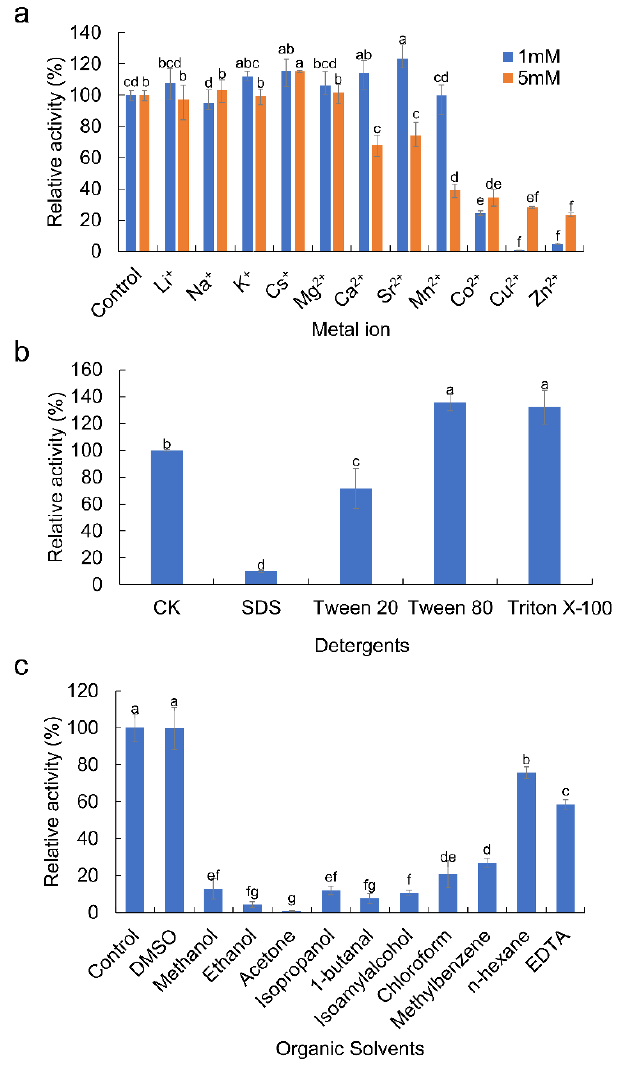
Figure 5. Effect of metal ions, detergents and organic solvents on esterase activity of EstDR4. ( a ) Effect of metal ions (1 and 5 mM) on EstDR4 activity: Li + , Na + , K + , Cs + , Mg 2+ , Ca 2+ , Sr 2+ , Mn 2+ , Co 2+ , Cu 2+ and Zn 2+ . ( b ) Effect of detergents on enzyme activity: SDS, Tween 20, Tween 80 and Triton X-100. ( c ) Effect of organic solvents (25% v / v ) on EstDR4 activity: dimethyl sulfoxide (DMSO), methanol, ethanol, acetone, isopropanol, 1-butanol, isoamyl alcohol, chloroform, methylbenzene and n-hexane. The relative activity of the control without metal ions, detergents and organic solvents was regarded as 100%. The different letters between each condition indicate significant differences ( p <